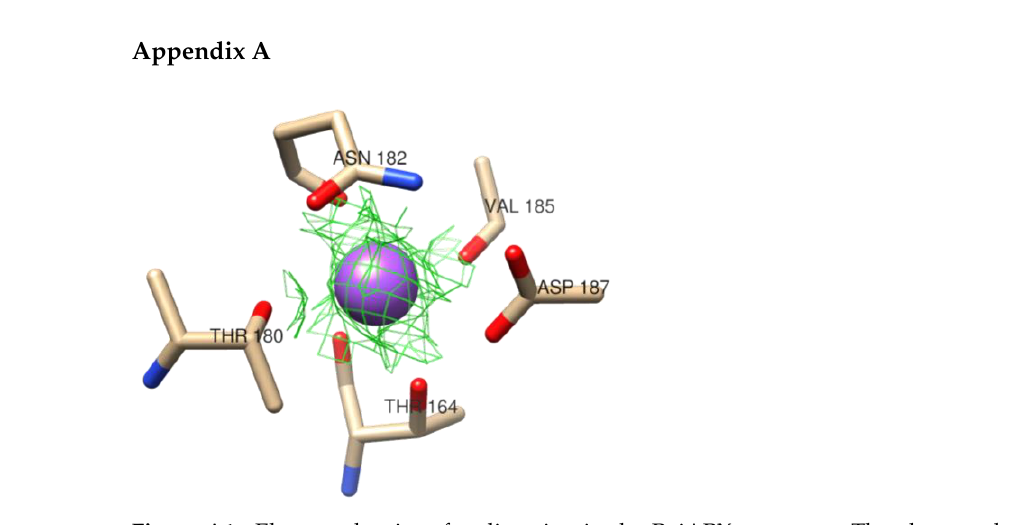
Figure A1. Electron density of sodium ion in the PviAPX structure. The electron density map at contour Level 1 showed a sodium ion. The Na+ ion was coordinated by the Thr-164, Thr-180, Asn-182, Asp-187 and Val-185. This figure was produced using the Chimera package (UCSF, NIH P41 RR-01081).